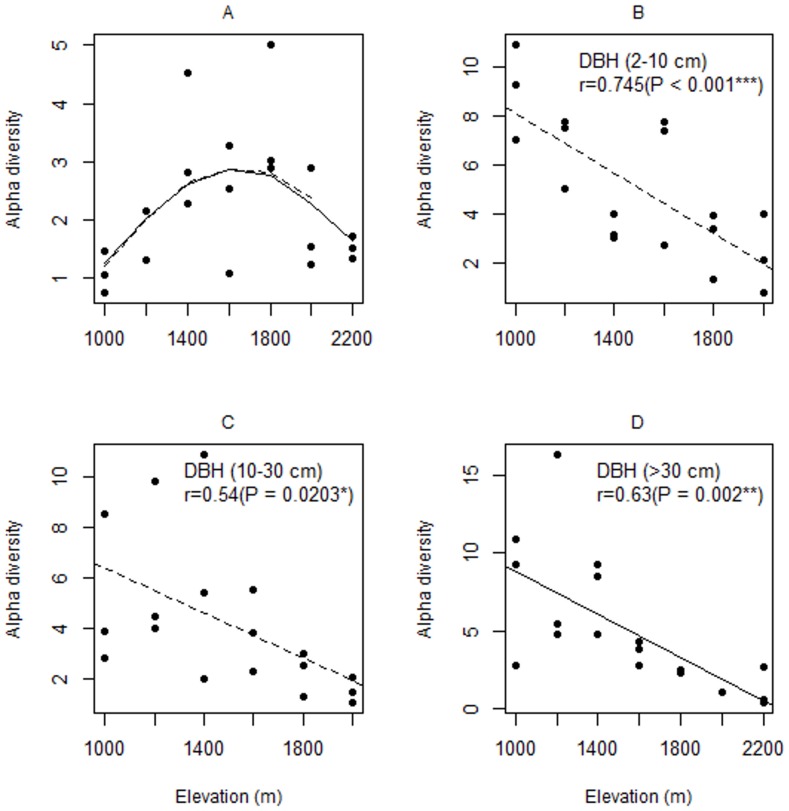
Relationships between elevation and alpha-diversity (Fisher's alpha) for different components of vegetation on Mt Rinjani, Indonesia.(A) ground-cover plants (y = 2.33+1.75x-2.39x2), (B) understorey plants (y = 14.24-0.006x), (C) subcanopy plants (y = 10.90-0.005x), (D) canopy plants (y = 16.43-0.007x). Solid lines indicate relationships including all elevation stations and the dashed lines indicate the relationships when the station at 2200 m (fire-maintained grassland) was omitted. Only relationships that were significant (p<0.05) in univariate regression models are shown.